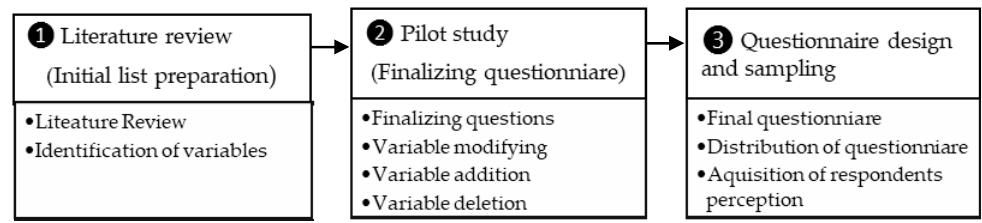
Figure 1. Data collection process.